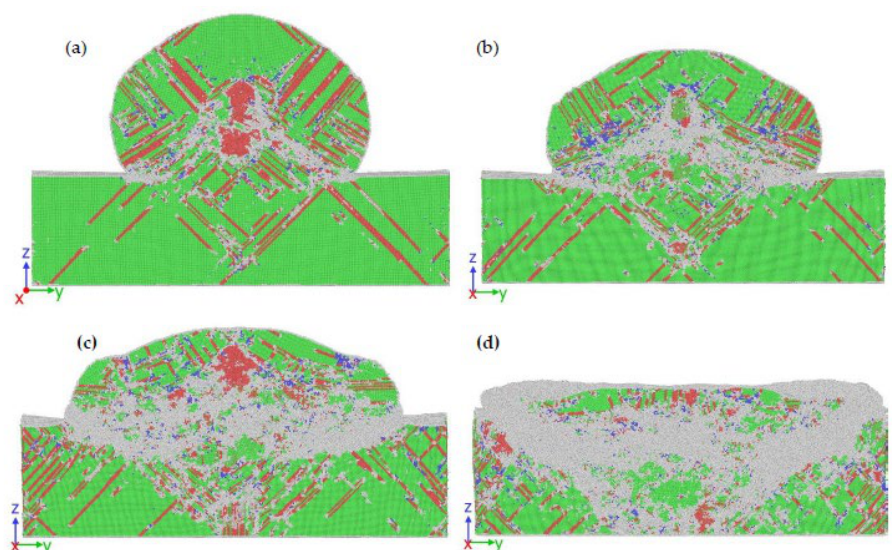
Figure 12. Microstructural snapshots presenting a structural transformation of a cold gas dynamic spray splat at 20 ps for: ( a ) 500 m/s, ( b ) 700 m/s, ( c ) 1000 m/s, and ( d ) 1500 m/s.